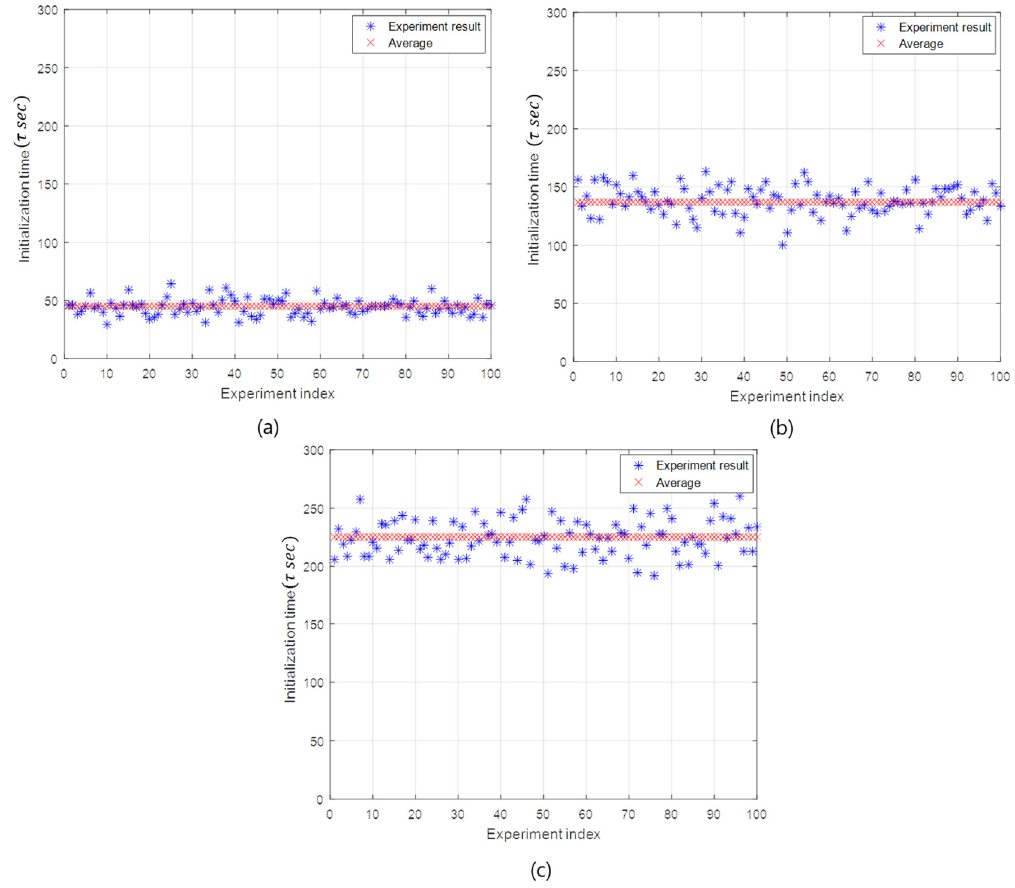
Figure 7. The initialization time of the API and the FI. ( a ) The API with the initialization rate 20%. ( b ) The API with the initialization rate 60%. ( c ) The FI with the initialization rate 100%.